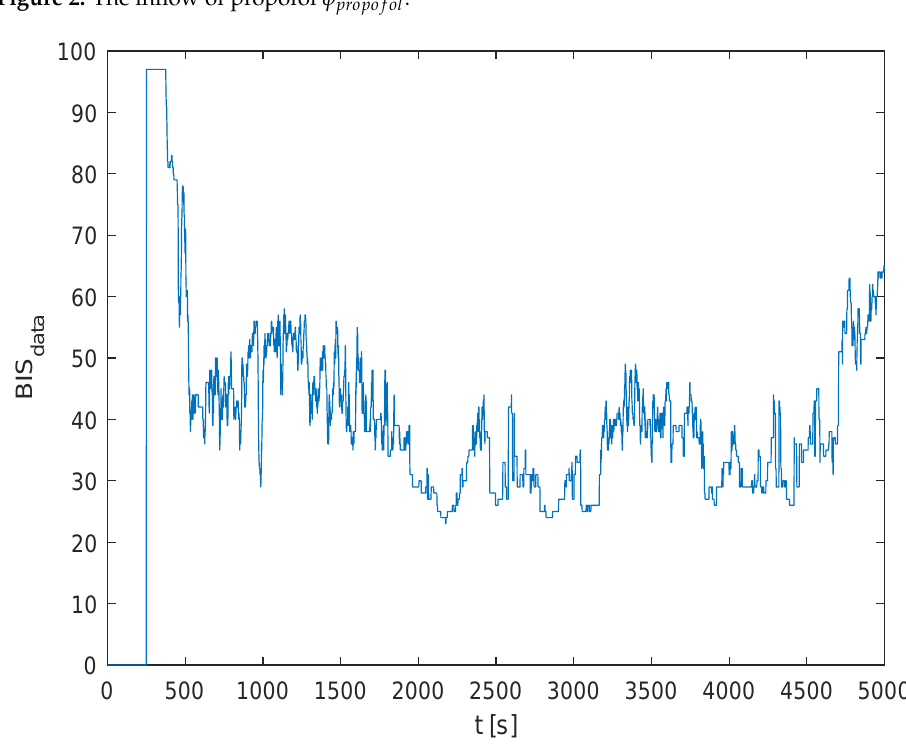
Figure 3. The measured BIS trajectory BIS data